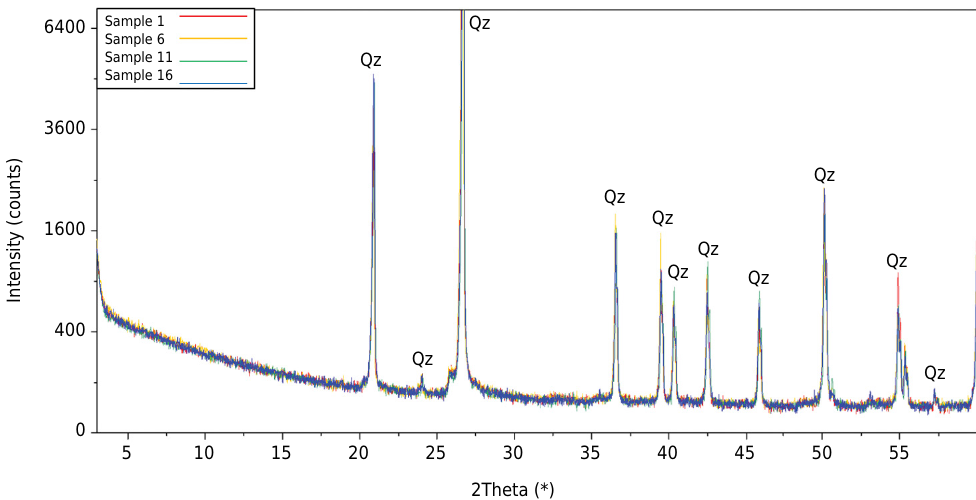
Figure 3. X-ray diffractograms of the sand fraction from four samples randomly selected in the different sites for illustrative purposes: samples 1 and 16 represent samples from Curitiba (claystone); and samples 6 and 11 represent samples from Colombo (marble) (Table 1). Qz: quartz.